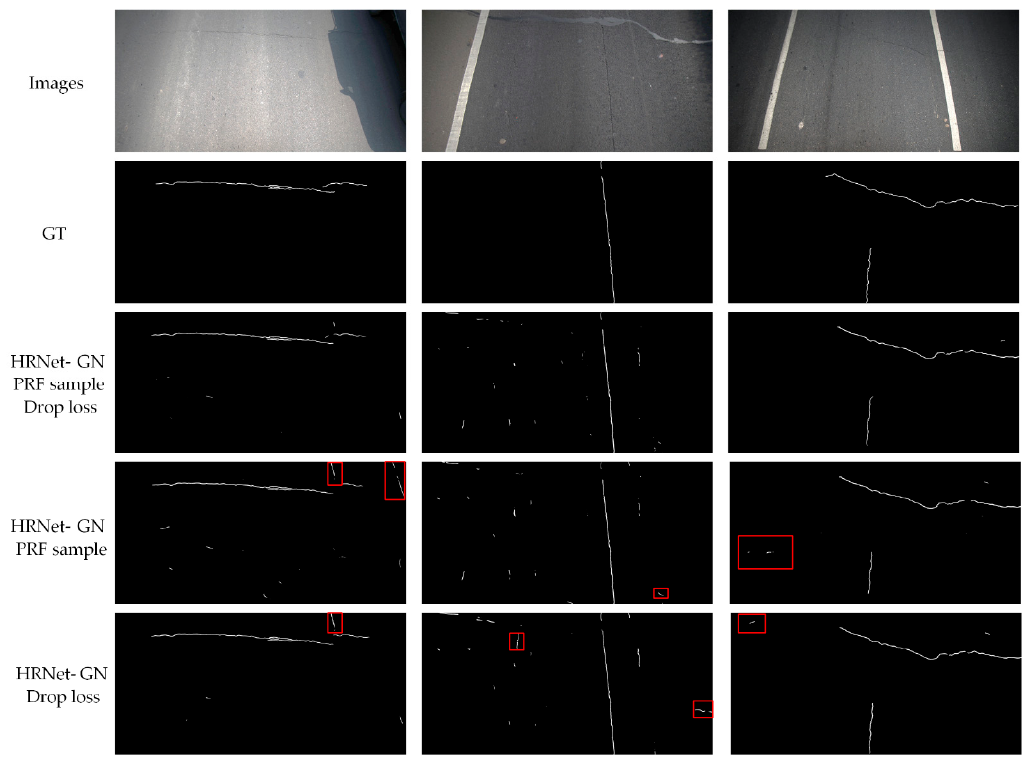
Figure 8. Results of ablation experiments (red boxes represent the regions of poor performance that model obtained from the single method training in the ablation